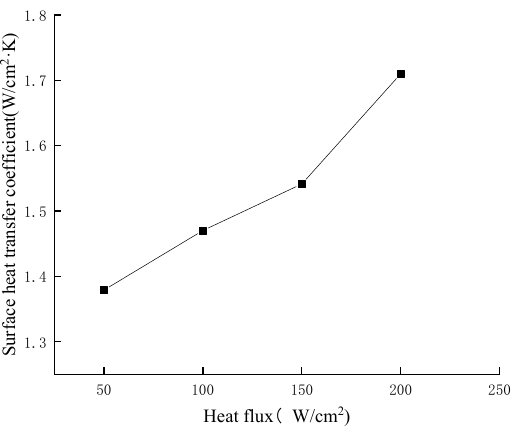
Figure 5. The influence of the change of heating heat flux on the steady-state surface heat transfer coefficient at a flow rate of 40 L/h.